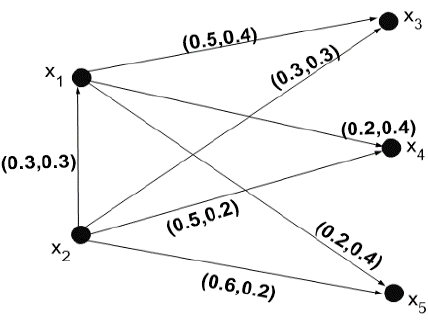
Figure 4. Intuitionistic fuzzy graph for water flow network.